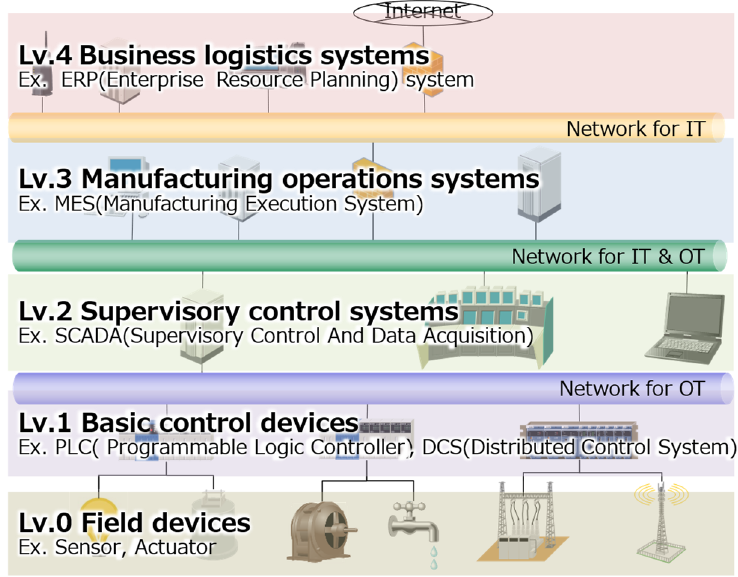
Figure 1. ANSI/ISA95 reference model used for ISA99 and IEC62443.